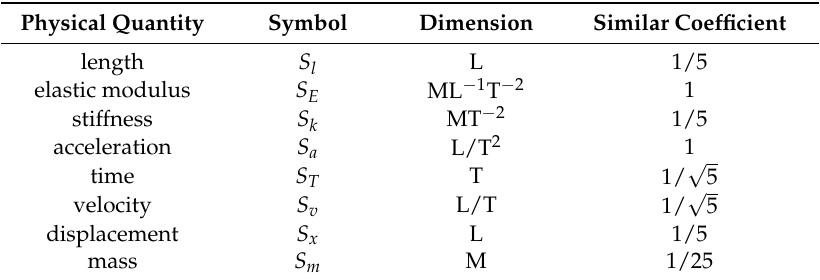
Table 1. The similar coefficient of the